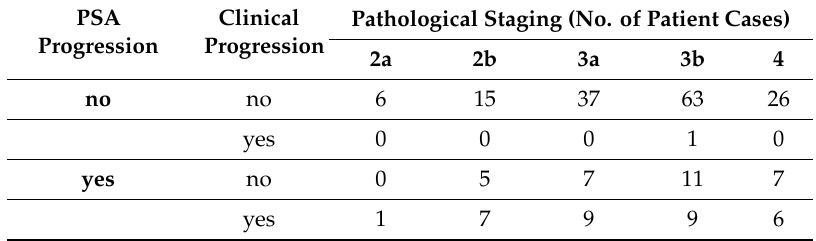
Table 2. Pathological staging, PSA and Clinical Progression of the EMPaCT TMA patient